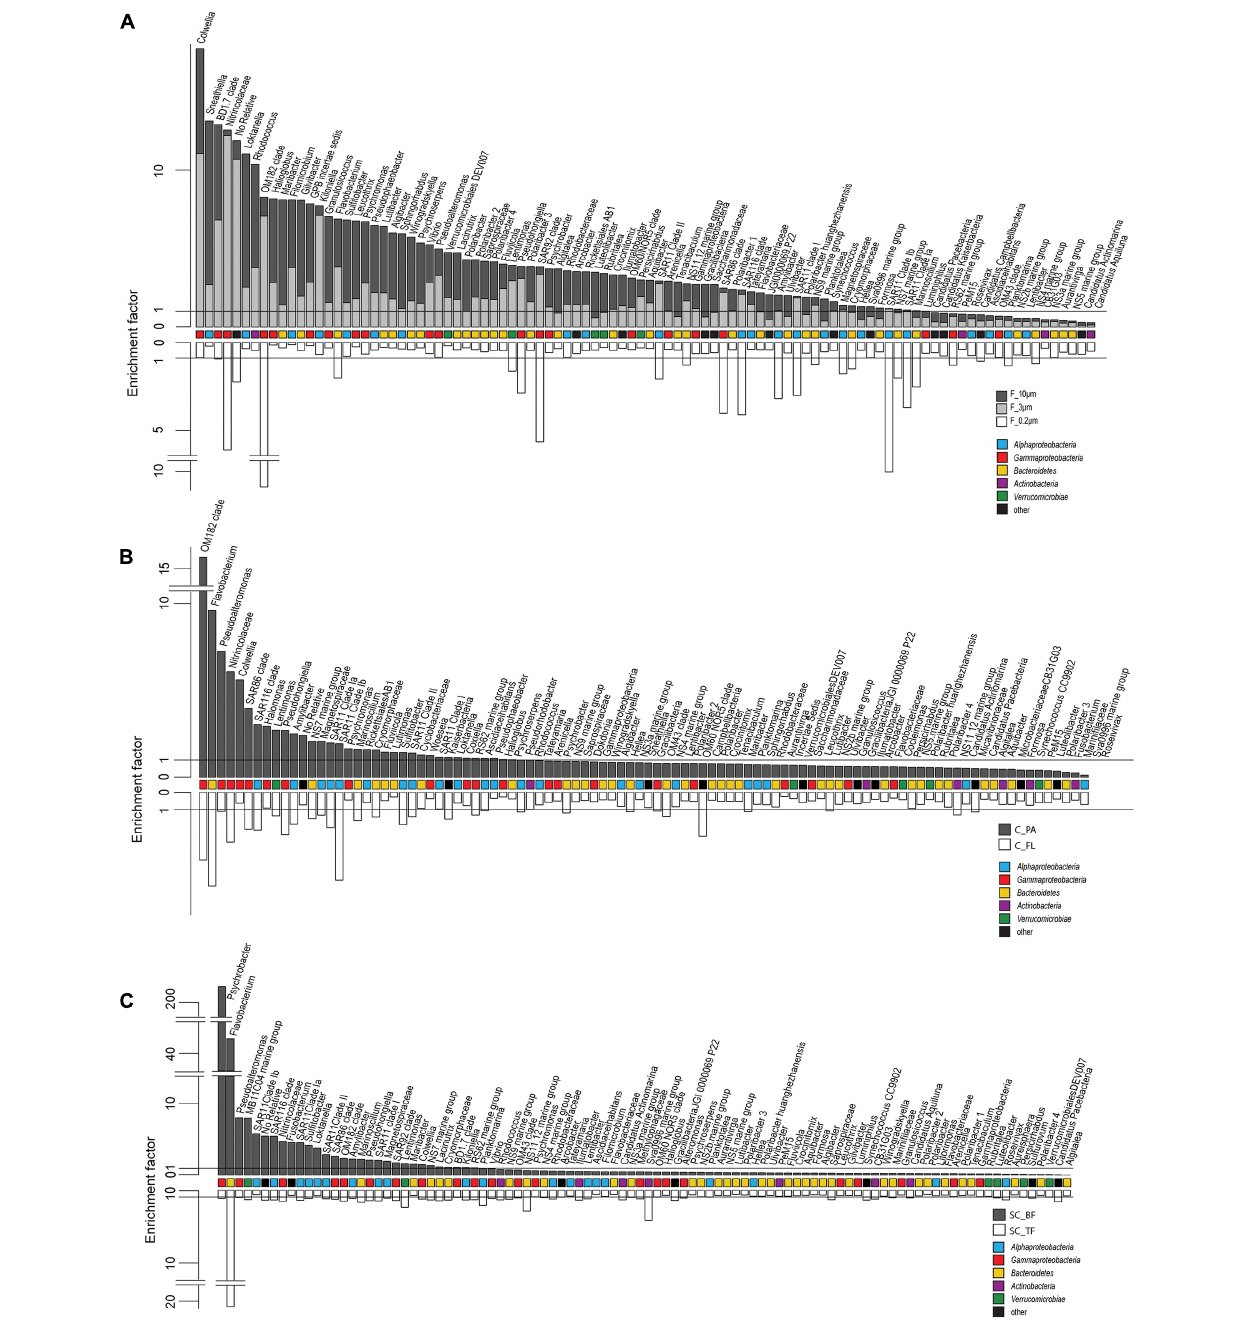
FIGURE 4 | Two-sided bar charts of operational taxonomic units (OTUs) with, on average, the highest relative read abundance in seawater and sorted by their mean enrichment factor across time points in (A) the filtration-derived particle fraction (F_10 µ m and F_3 µ m), (B) centrifugation-derived particle fraction (C_PA), and (C) sedimentation cone derived bottom fraction (SC_BF) ( gray and dark gray ). Samples were obtained during a phytoplankton spring bloom off Helgoland (North Sea) in 2018. White , free-living (C_FL/F_0.2 µ m) and top fraction (SC_TF).